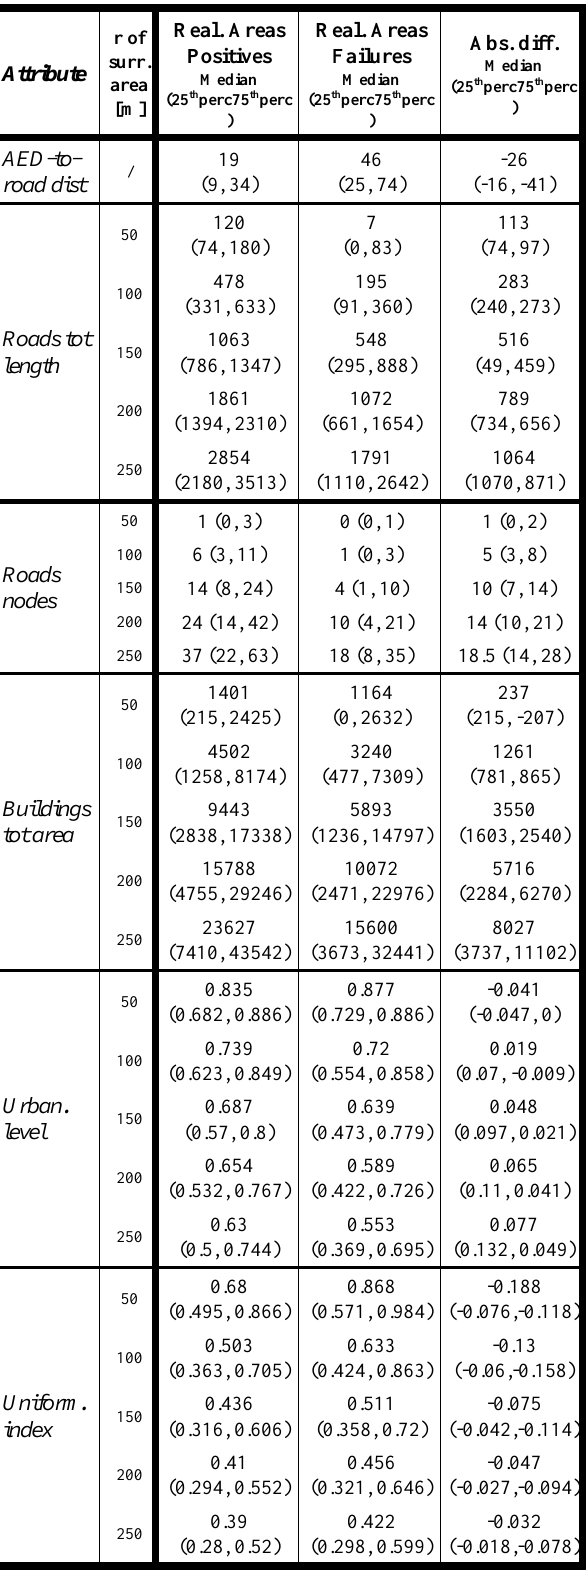
Table 2. Median, 25 th and 75 th percentile of all attributes (see text at 2.4 for definition details) for realistic areas, circular areas, and difference between the two